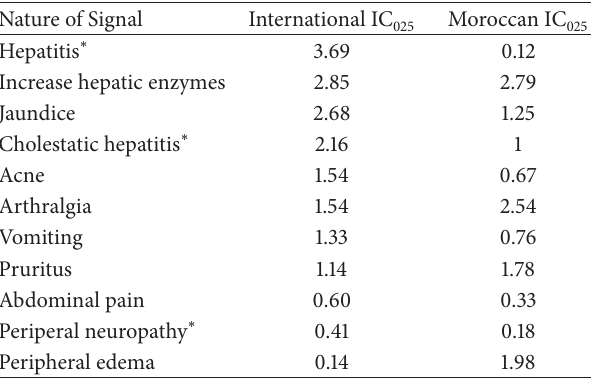
Table 6: Moroccan signals with anti-TB combined